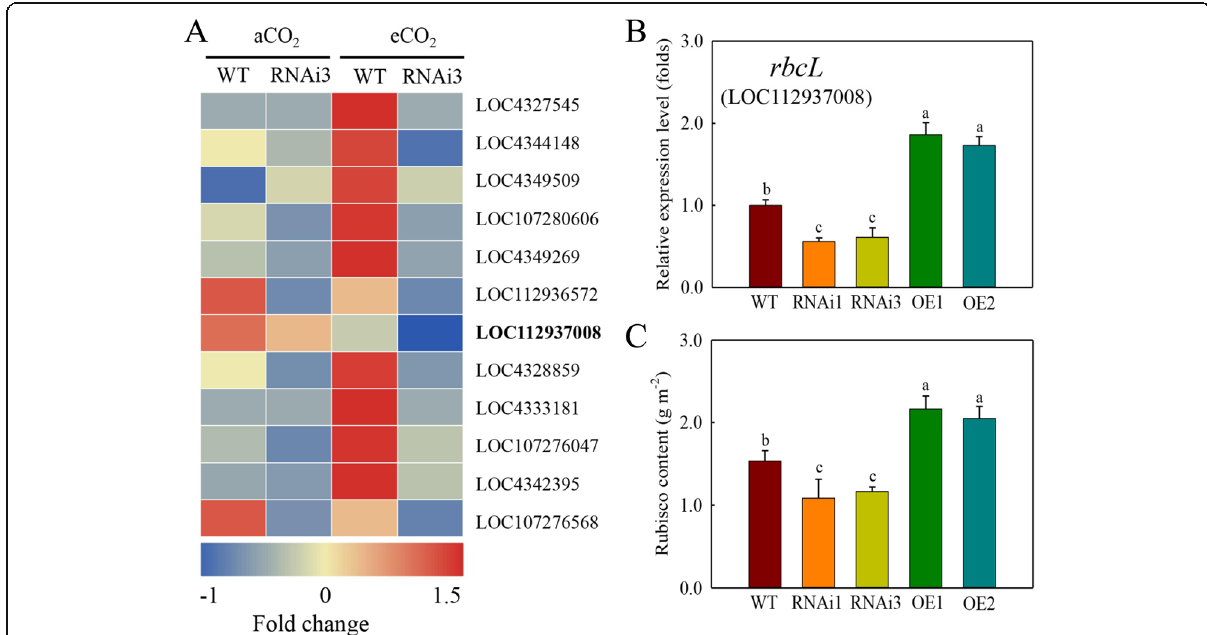
Fig. 6 qPE9-1 regulates Rubisco gene expression and its content in rice plants aCO 2 or eCO 2 . Seedlings were grown in growth chambers under aCO 2 (400 ppm) or eCO 2 (800 ppm) for 4 weeks. ( A )Heat map of the genes related to photosynthesis in leaves of WT and RNAi3 lines. The scale shows fold change, red indicates upregualtion and blue is downregulation. ( B ) Relative expression level of rbcL in leaves of WT and transgenic lines ( n = 3). ( C ) The content of Rubisco in leaves of WT and transgenic lines ( n = 5). All values are means± SD; different letters indicate significant differences ( P <